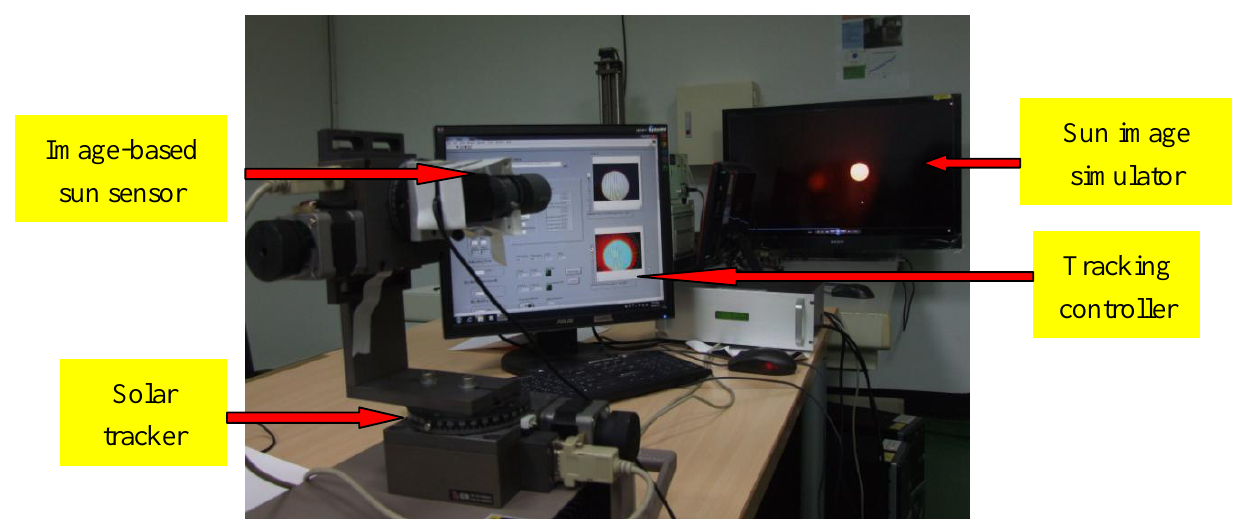
Figure 9. Sun image tracking platform.